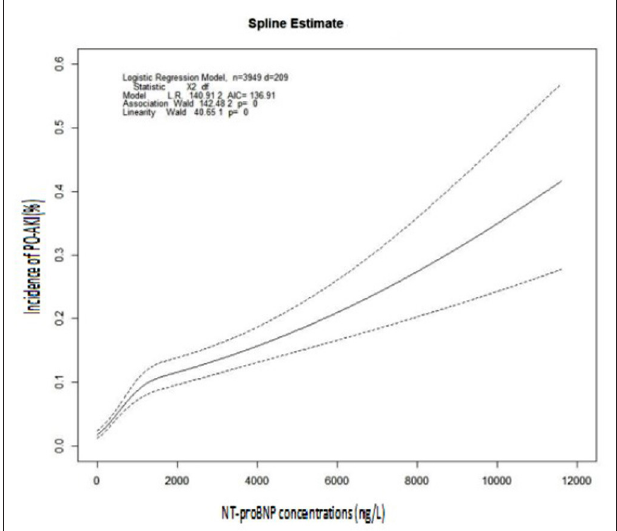
FIGURE 2 | Restricted cubic spline regression of the association between NT-proBNP and post-operative AKI. The incidence of PO-AKI ( y -axis) as a function of pre-operative NT-proBNP concentrations (ng L − 1 , x -axis). The dotted line indicates 95% CIs. There was a positive correlation between pre-operative NT-proBNP concentrations and the incidence of